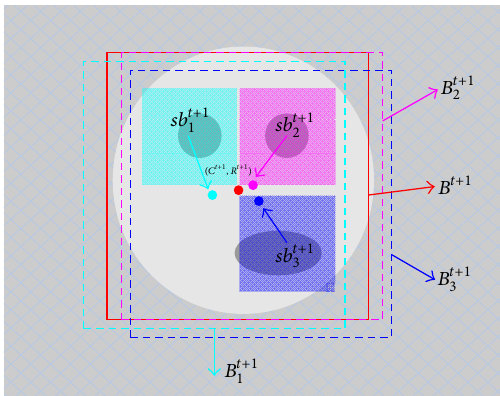
Figure 6: The process of locating object. The green, pink, and blue patches are the local feature blocks 𝑠𝑏 𝑡+1 1 , 𝑠𝑏 𝑡+1 2 , and 𝑠𝑏 𝑡+1 3 , and the green, blue, and pink dotted line rectangles are the corresponding tracking results 𝐵 𝑡+1 1 , 𝐵 𝑡+1 2 , and 𝐵 𝑡+1 3 . The red solid line rectangle represents the final tracking result 𝐵 𝑡+1 , which is located by tracking results of local feature